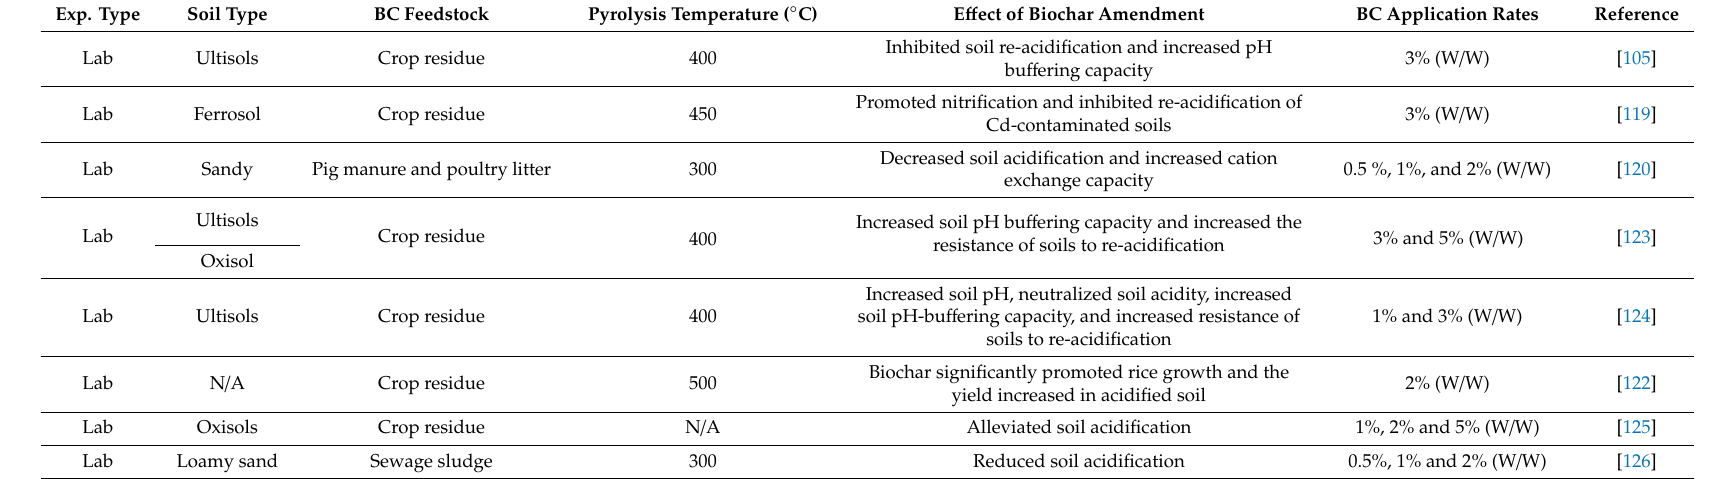
Table 2. Selected recent studies documenting the impact of biochar on acidified